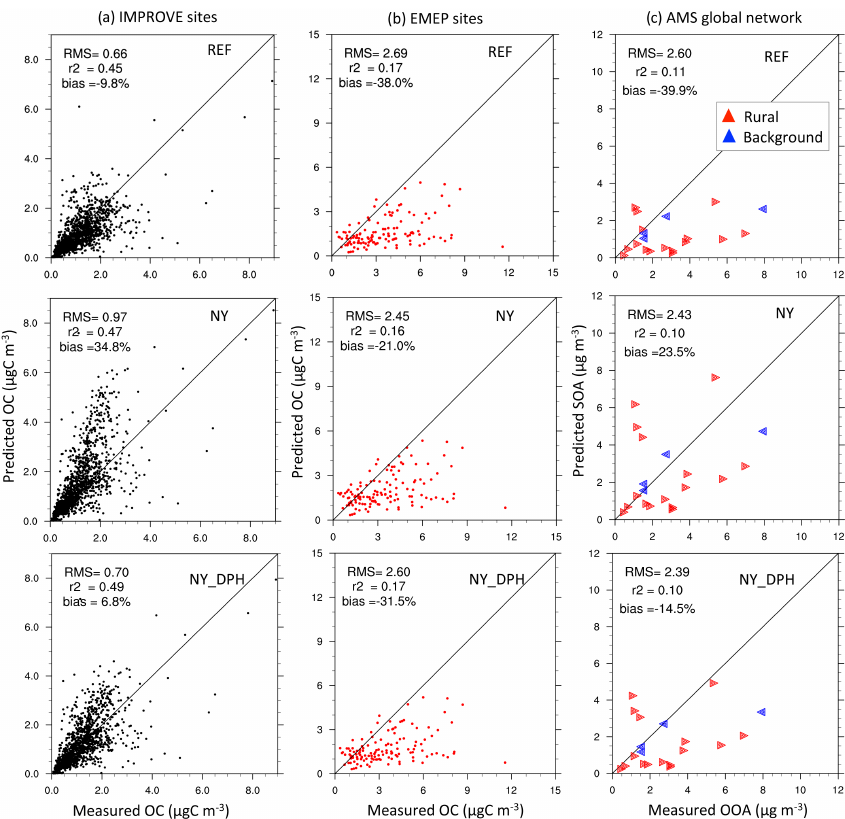
Figure 4. Scatter plots of predicted vs. measured monthly mean OC (µgCm − 3 ) and SOA (µgm − 3 ) at the surface sites of the US IMPROVE network, the European EMEP network and the global AMS network. AMS data are divided into rural sites (red) and background sites (blue). Given model coarse horizontal resolution, urban sites were not considered.Modeled monthly mean values are representative of years 2005 to 2008 and are compared with monthly mean observations averaged over 2005–2008 for IMPROVE, 2002–2003 for EMEP, and 2000–2008 for AMS